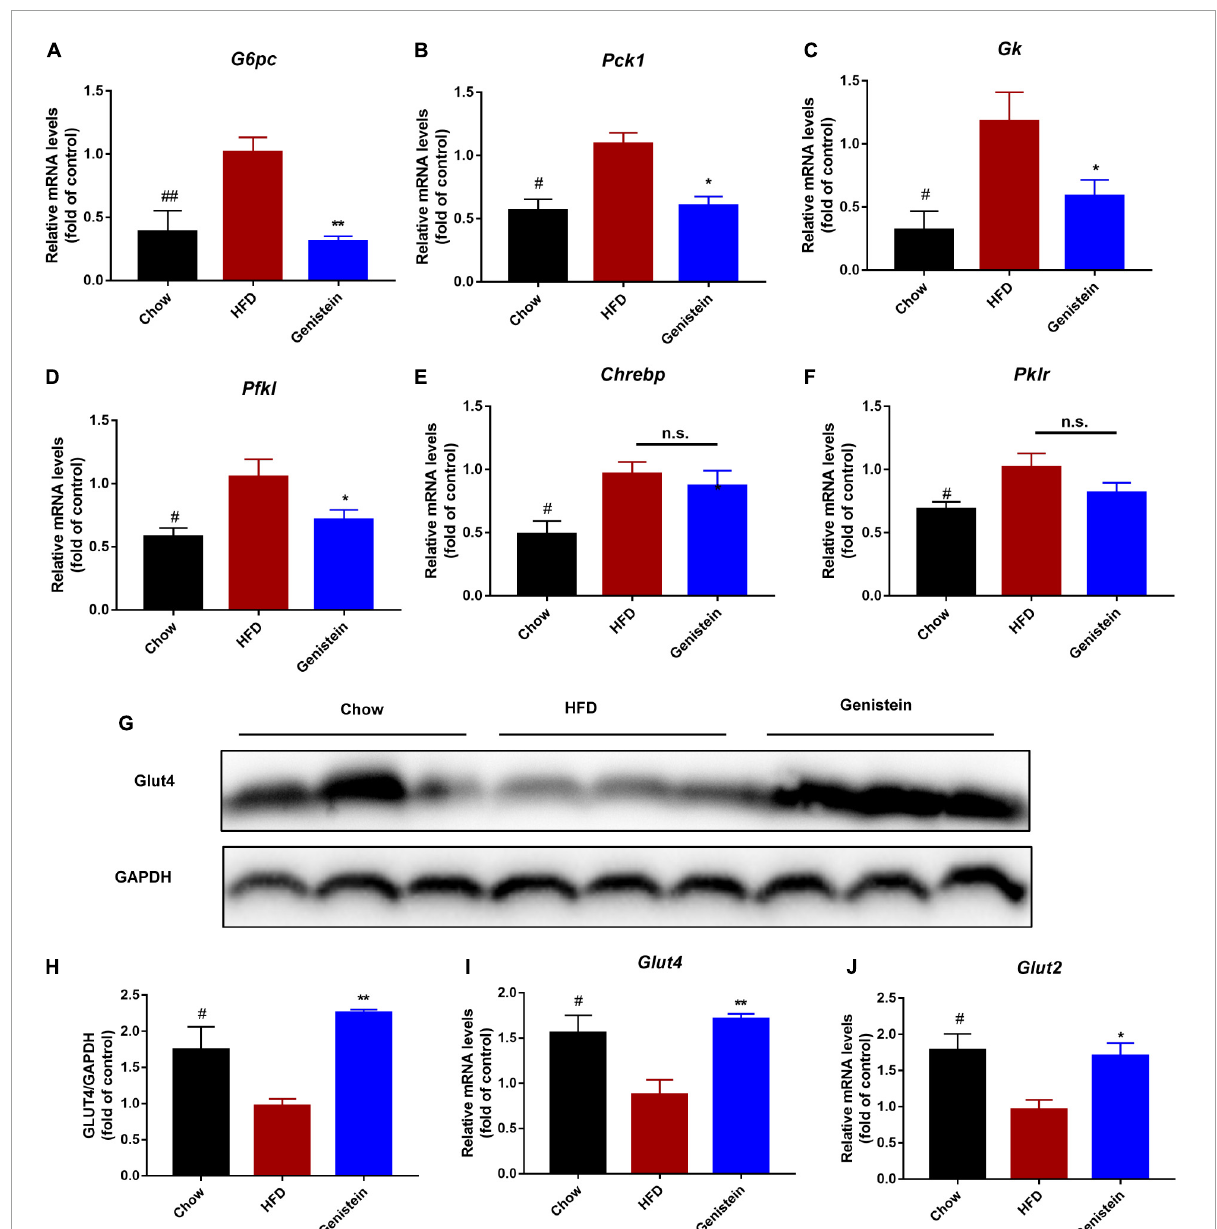
FIGURE4 Genistein regulates the expression of glucose metabolism genes (A–F) qRT-PCR analysis of G6pc , Pck1 , Gk , Pfkl , Chrebp, and Pklr in liver tissue of different groups. (G) Western blot for Glut4 in mice liver. (H) Quantification for Glut 4. (I,J) qRT-PCR analysis of Glut4 and Glut2 in liver tissue of different groups. Data are presented as means ± SEM; n = 4–5 mice/group. # p < 0.05 and ## p < 0.01 for Chow vs. HFD. * p < 0.05 and ** p < 0.05 for Genistein vs.